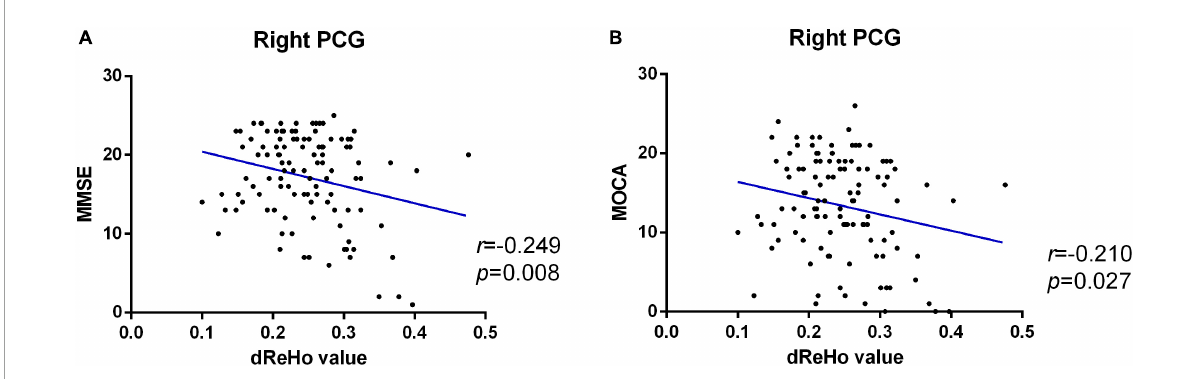
FIGURE3 Significant negative correlation between altered dReHo variability in the right PCG and MMSE (A) and MoCA (B) scores of patients with AD. dReHo, dynamic regional homogeneity; AD, Alzheimer’s disease; PCG, posterior cingulate gyrus; MMSE, mini-mental state examination; MoCA, Montreal Cognitive